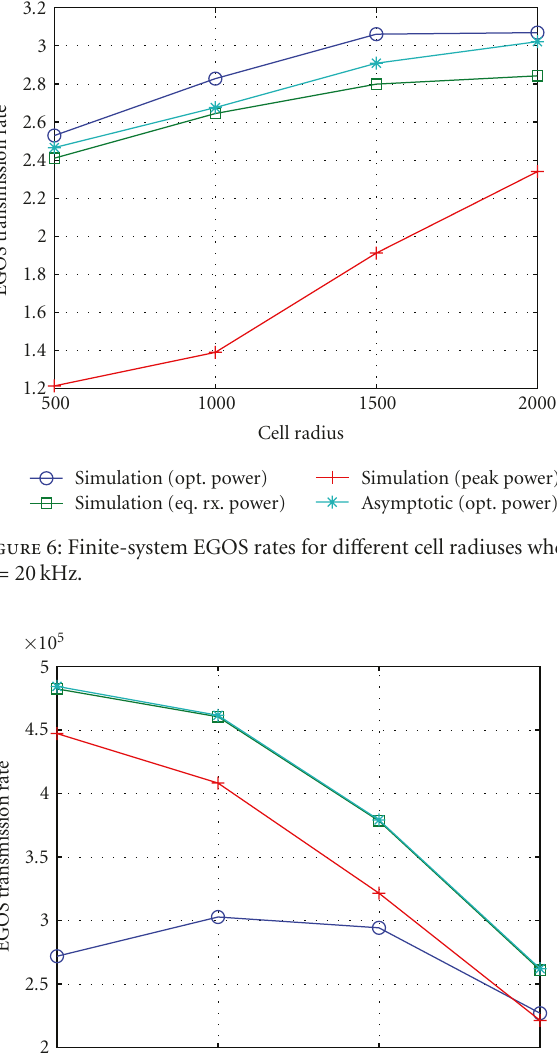
allocation has similar performance to that of the equal receive power scheme and is close to